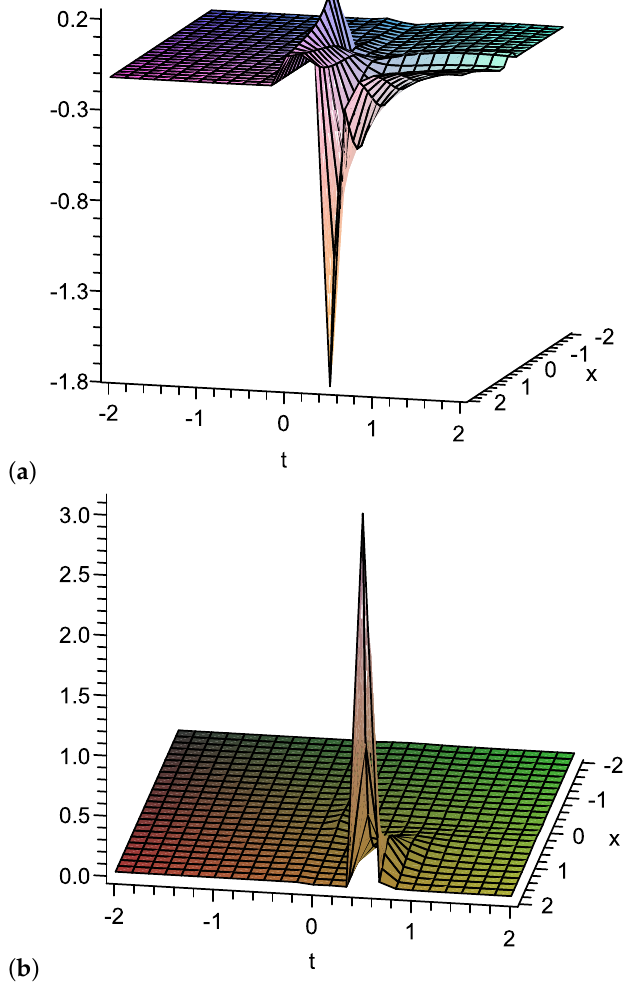
Figure 9. The first and second moments for the random solution ˜ sq random variable and − 2 ≤ t , x ≤ 2.